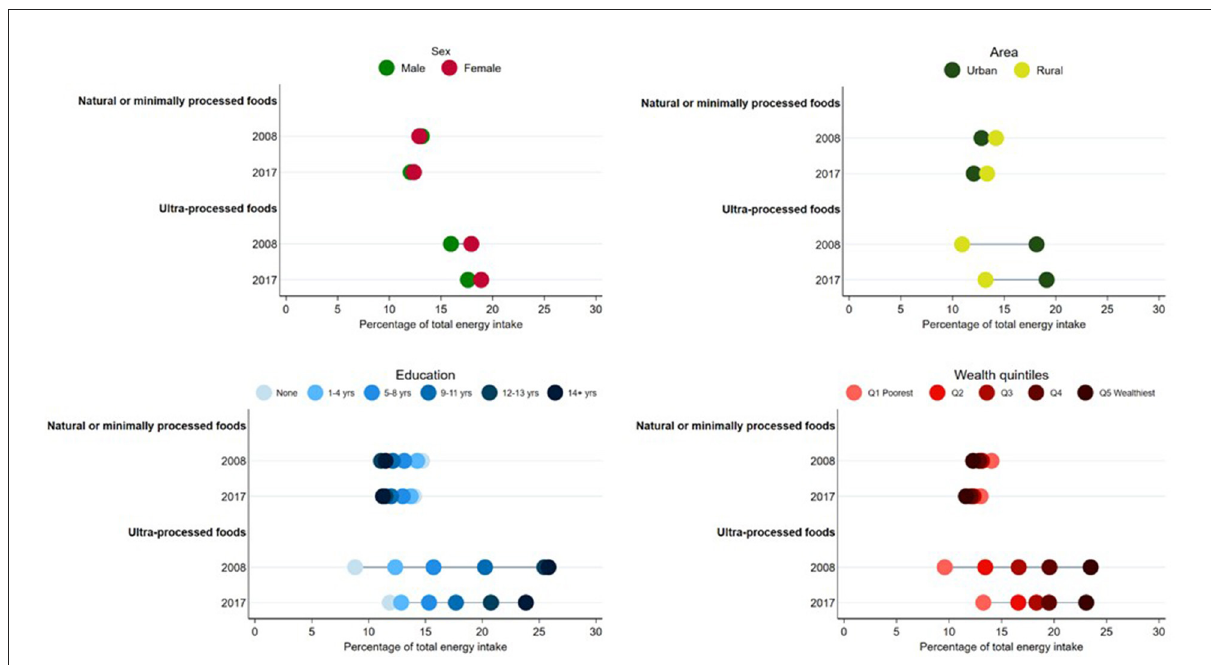
FIGURE2 Percentage of total energy intake from the set of healthy foods and ultra-processed foods by sex, area of residence, education, and wealth quintiles in 2008 and 2017.